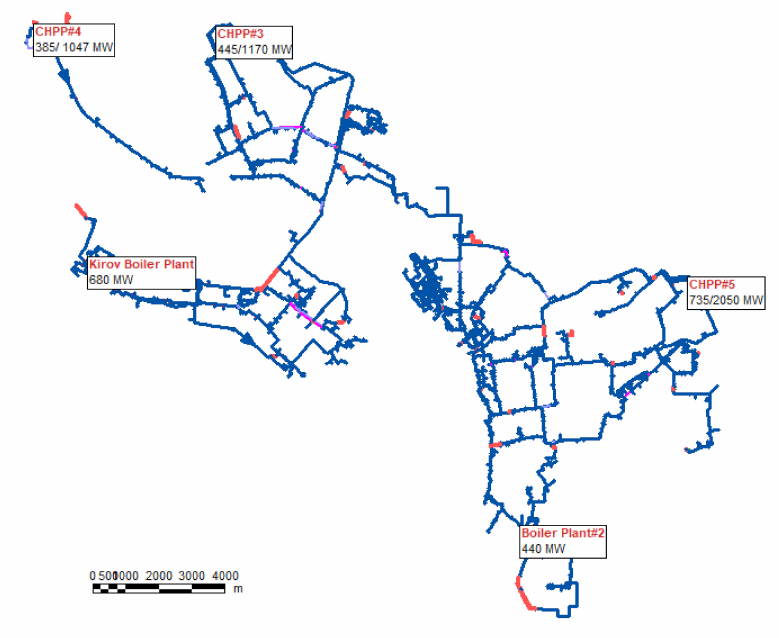
Figure 1. Model of the Omsk DH system analyzed in this